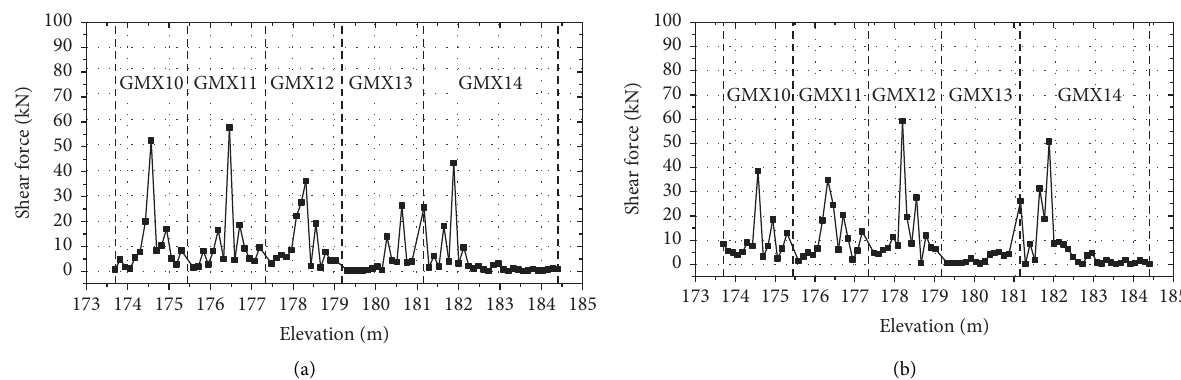
Figure 18: Vertical shear force distribution of studs along height of the cable tower. (a) Shear force of 17 th -row studs of midspan. (b) Shear force of 17 th -row studs of side